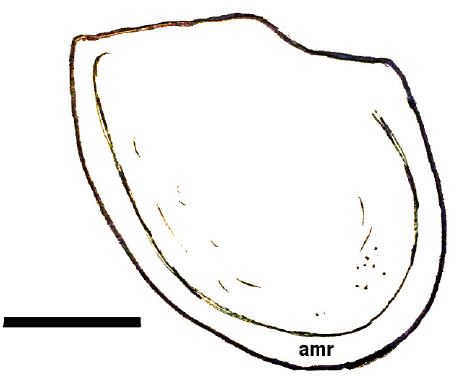
Figure 21. Liangshanella circumbolina . Anterior to left. Scale bar 500 microns. Abbreviation: amr , admarginal rim. Image Credit: Mark McMenamin.